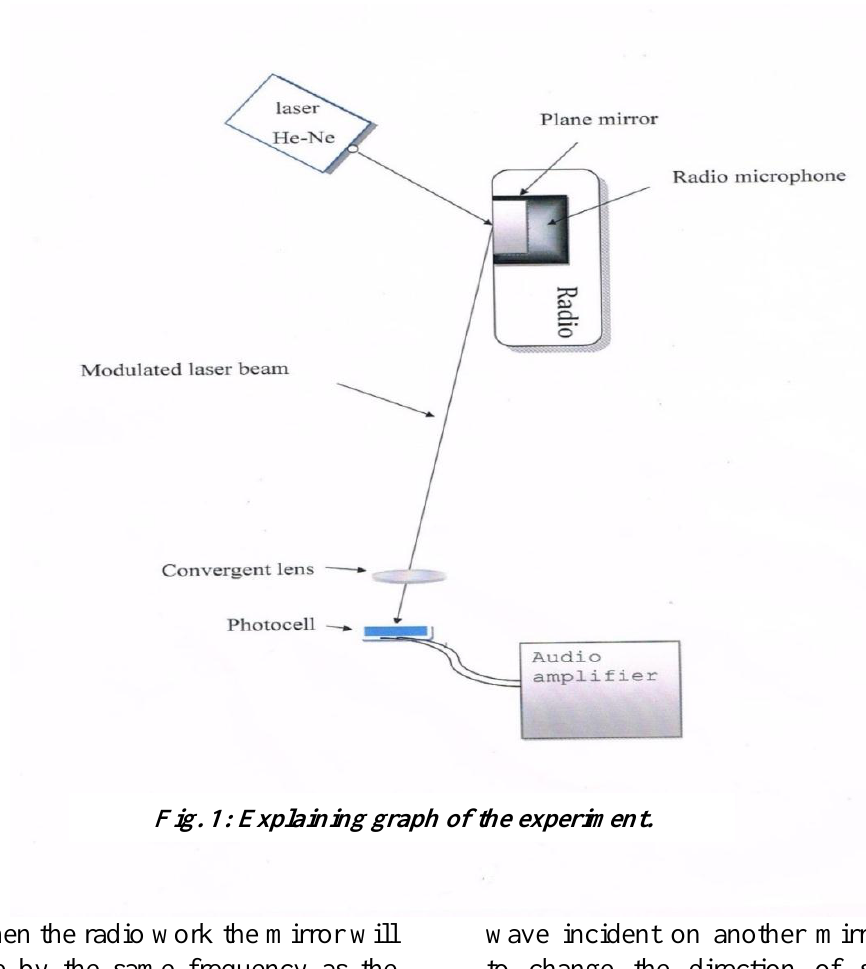
Fig. 1: Explaining graph of the